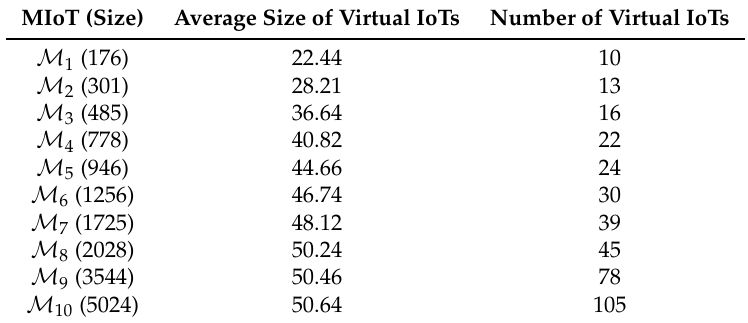
Table 14. Average size and number of virtual IoTs against the increase of the MIoT size (unsupervised